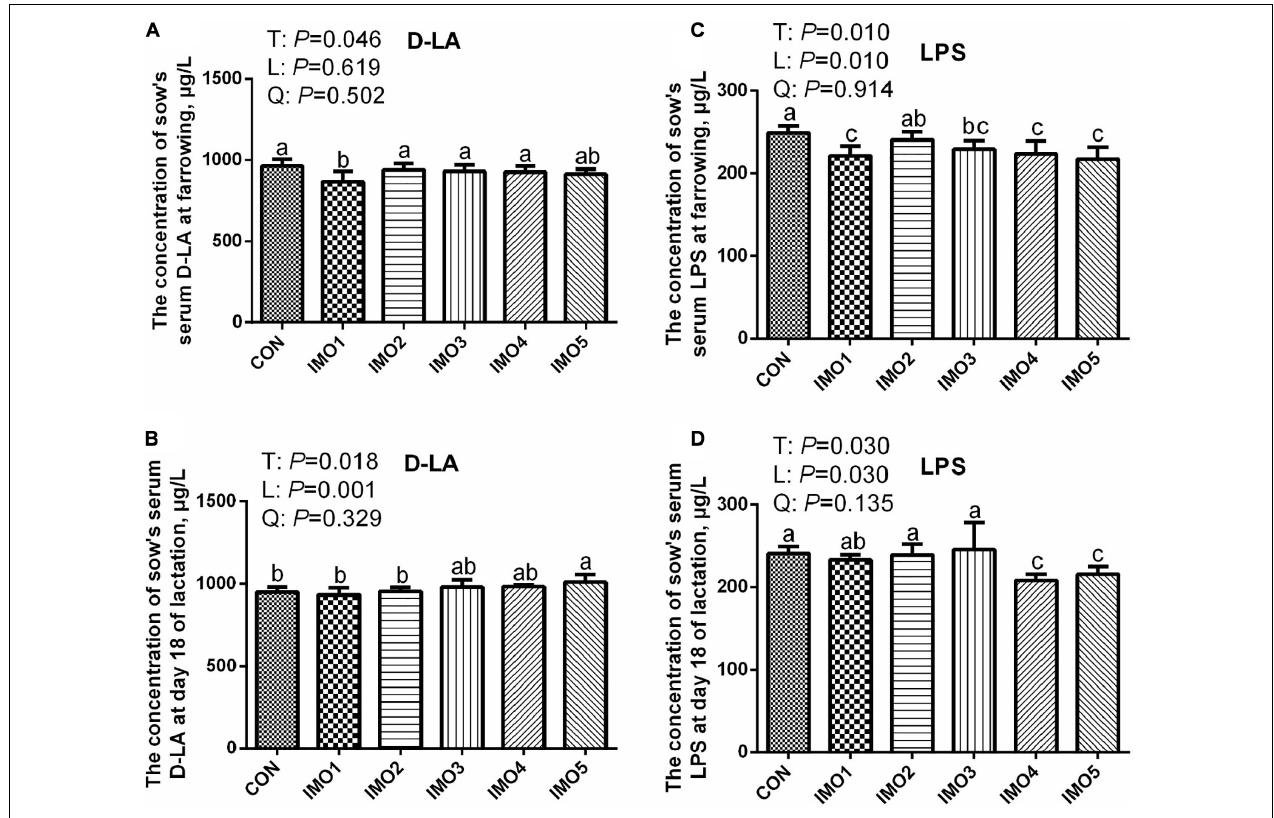
FIGURE 4 | Effects of dietary isomaltooligosaccharide (IMO) levels on the concentrations of sows’ serum D-LA (A) and LPS (C) at farrowing as well as serum D-LA (B) and LPS (D) at day 18 of lactation. Data are presented as means ± SD ( n = 7). (a–c) Significant effect of treatment ( P < 0.05; values with different lowercase letters are significantly different; T, total; L, linear; Q, quadratic).